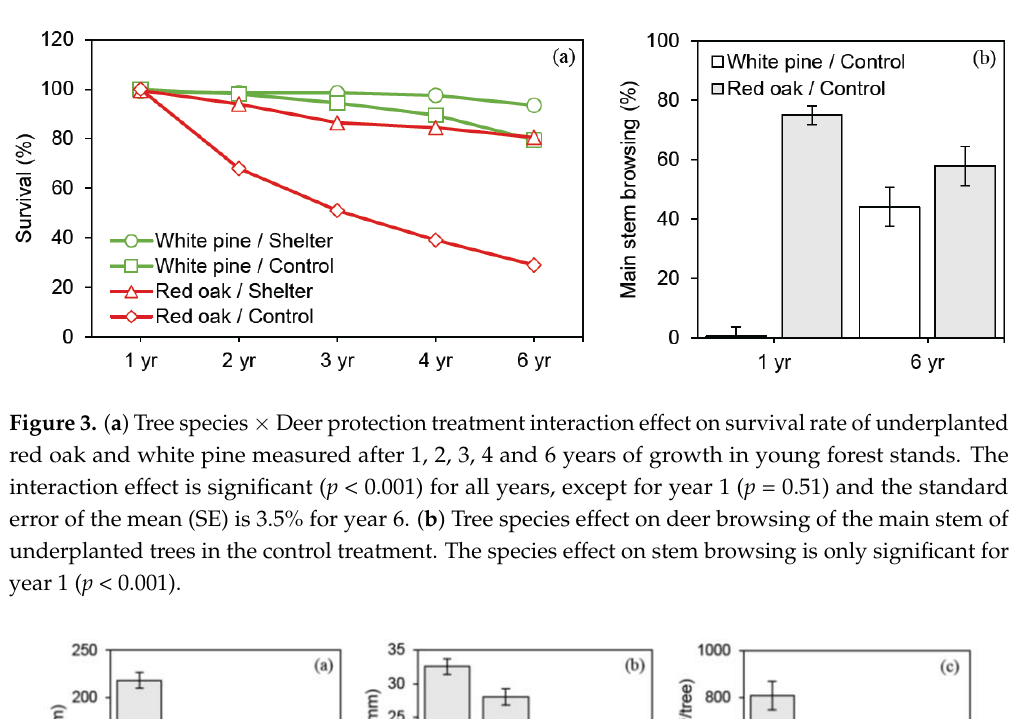
that of bitternut hickory (64% vs. 90%, respectively), stem volume of walnut was 5.5 times higher than stem volume of hickory. However, height growth of both species was similar after 6 years.